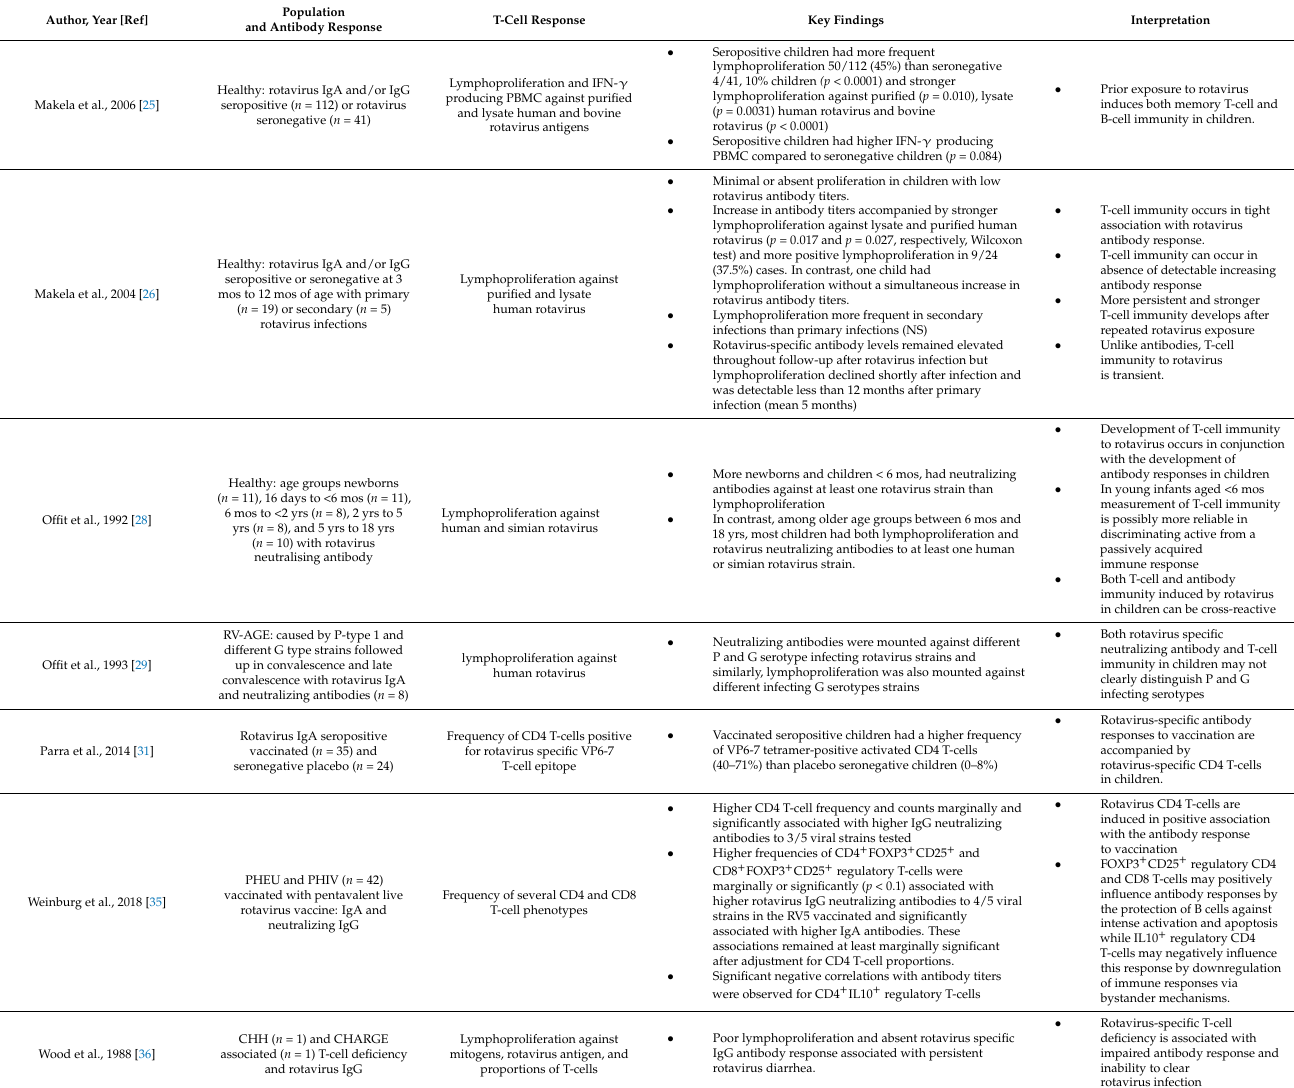
Table 3. Rotavirus T-cell proliferation, frequencies, and phenotypes in relation to an antibody